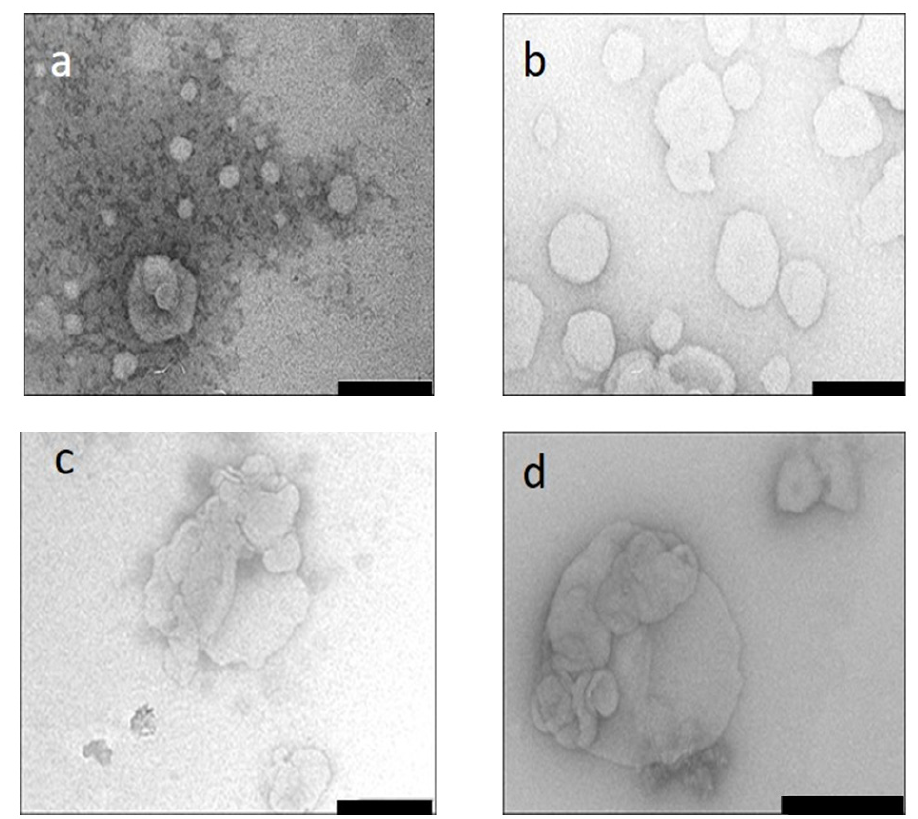
Figure 1. Transmission electron micrographs. Samples were viewed after uranyl acetate negative staining and flash freezing in liquid nitrogen. ( a ) MS09:DOPE, ( b ) MS09:Chol ( c ) MS09:DOPE:siRNA ( d ) MS09:Chol:siRNA. Bar = 200